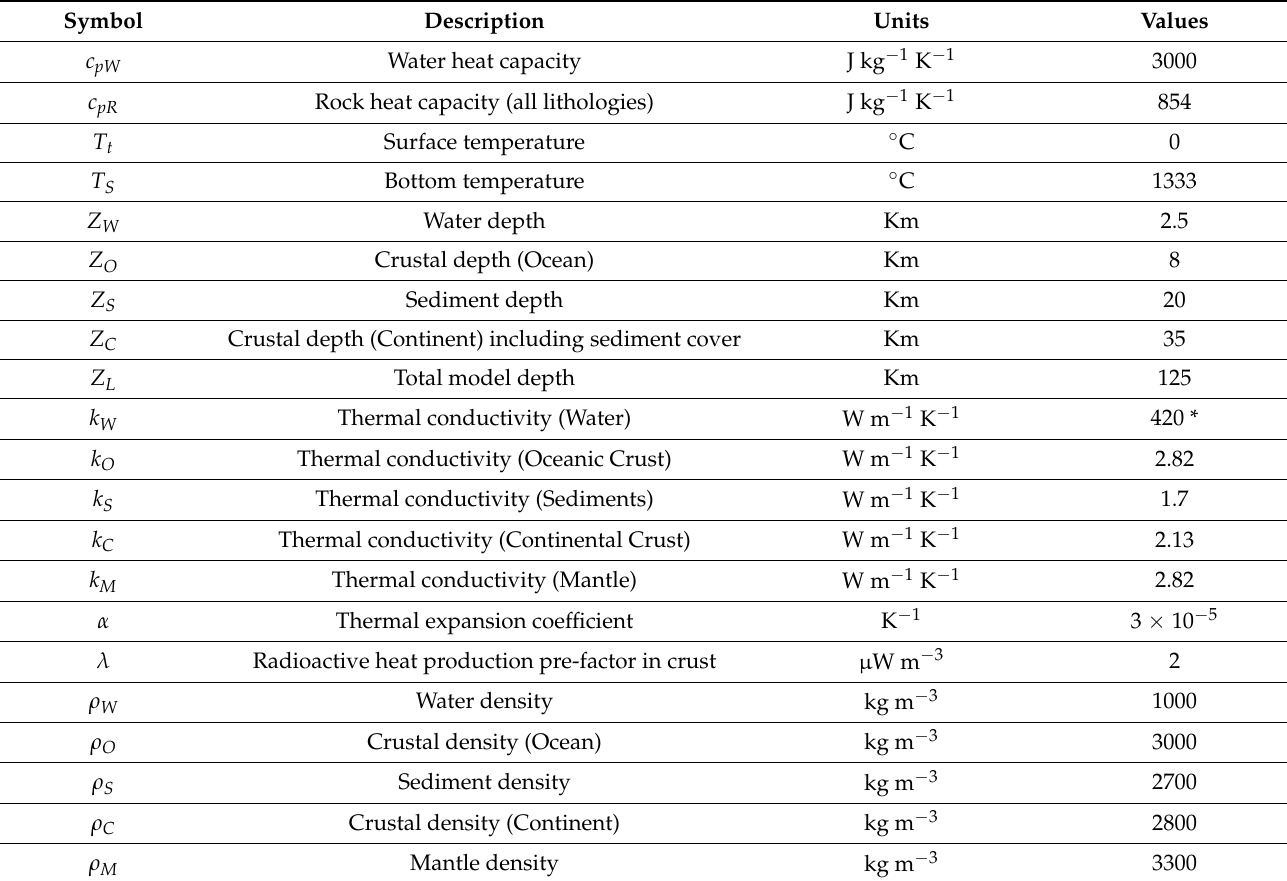
Table 1. List of symbols and values used in the numerical